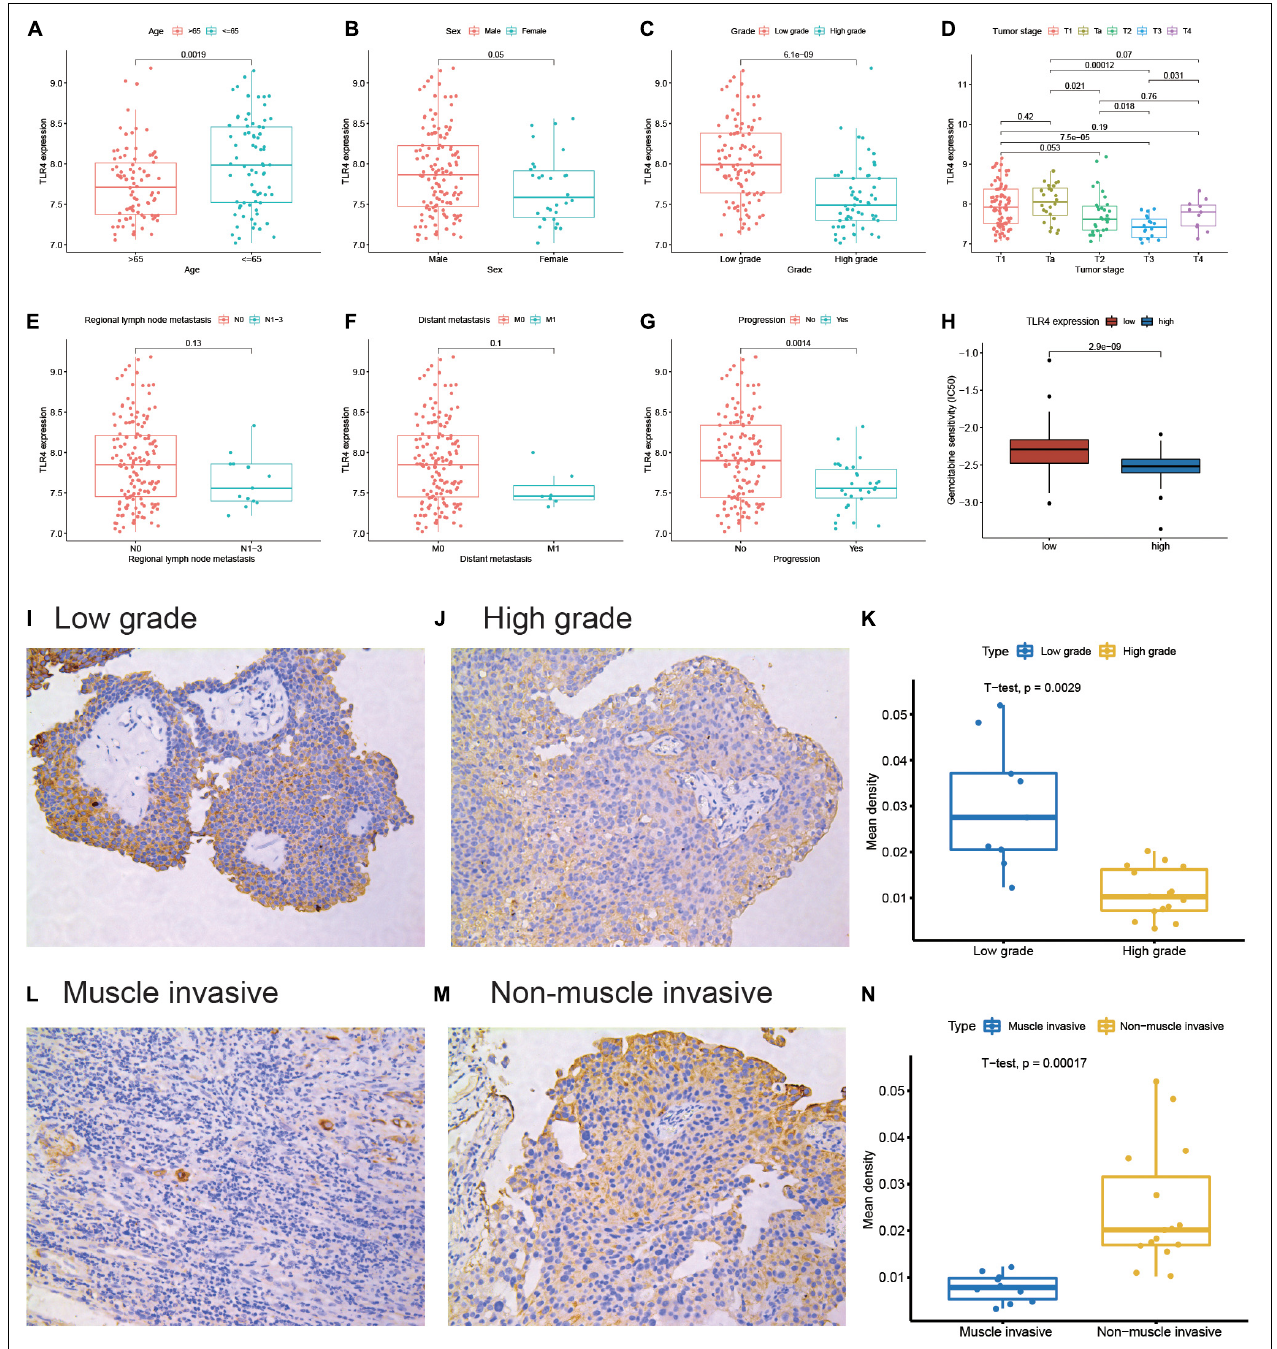
FIGURE 2 | Differential expression of TLR4 in clinicopathological subgroups. The subgroups are performed for age (A) , sex (B) , pathological grade (C) , tumor stage (D) , regional lymph node metastasis (E) , distant metastasis (F) , and progression (G) . The correlation between TLR4 expression and gemcitabine sensitivity (H) . The representative TLR4 immunohistochemistry images for a low-grade sample (I) and a high-grade sample (J) . The quantitative result (K) is illustrated for a low-grade group ( n = 9) and a high-group ( n = 16). The representative TLR4 immunohistochemistry images for the muscle invasive sample (L) and non-muscle invasive sample (M) . The quantitative result (N) is illustrated for the muscle invasive group ( n = 10) and non-muscle invasive group ( n = 15).